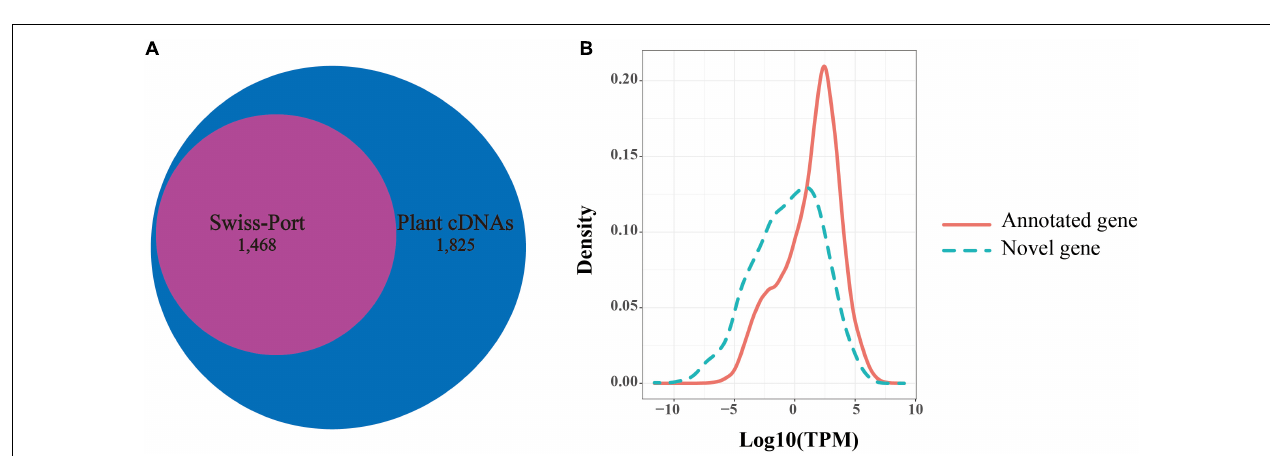
FIGURE 3 | Polymerase Chain Reaction validation of wrongly split genes. RT-PCR validation of wrongly split genes. The schematic representation of genes and full-length reads is shown. Gene structures in blue shows mis-annotated genes in the previous annotation. The gray boxes indicate isoform exons. Forward and reverse primers are shown as red arrows.